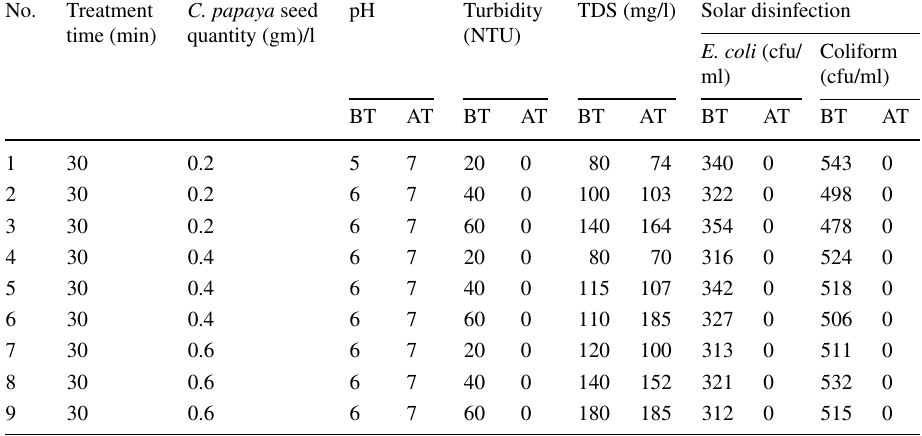
Table 2 Effect of C. papaya seed powder and solar disinfection on various turbid